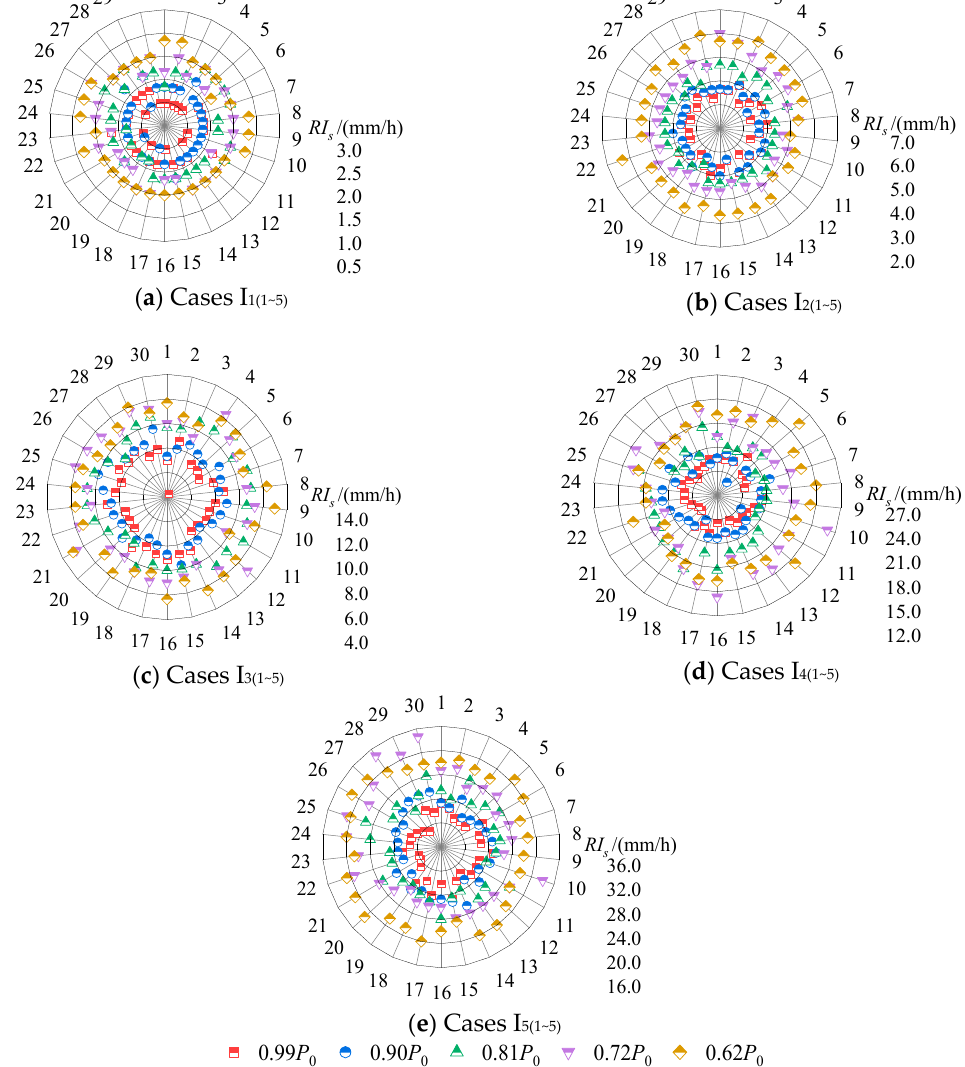
Figure 6. Instantaneous rain intensity of inclined plane affected by low ambient pressure (time notes along circumferential direction). ( a ) Q = 115.39 m 3 / h and V = 10.68 m / s; ( b ) Q = 119.97 m 3 / h and V = 11.11 m / s; ( c ) Q = 124.74 m 3 / h and V = 11.55 m / s; ( d ) Q = 126.00 m 3 / h and V = 11.67 m / s; ( e ) Q = 127.68 m 3 / h and V = 11.82 m / s.